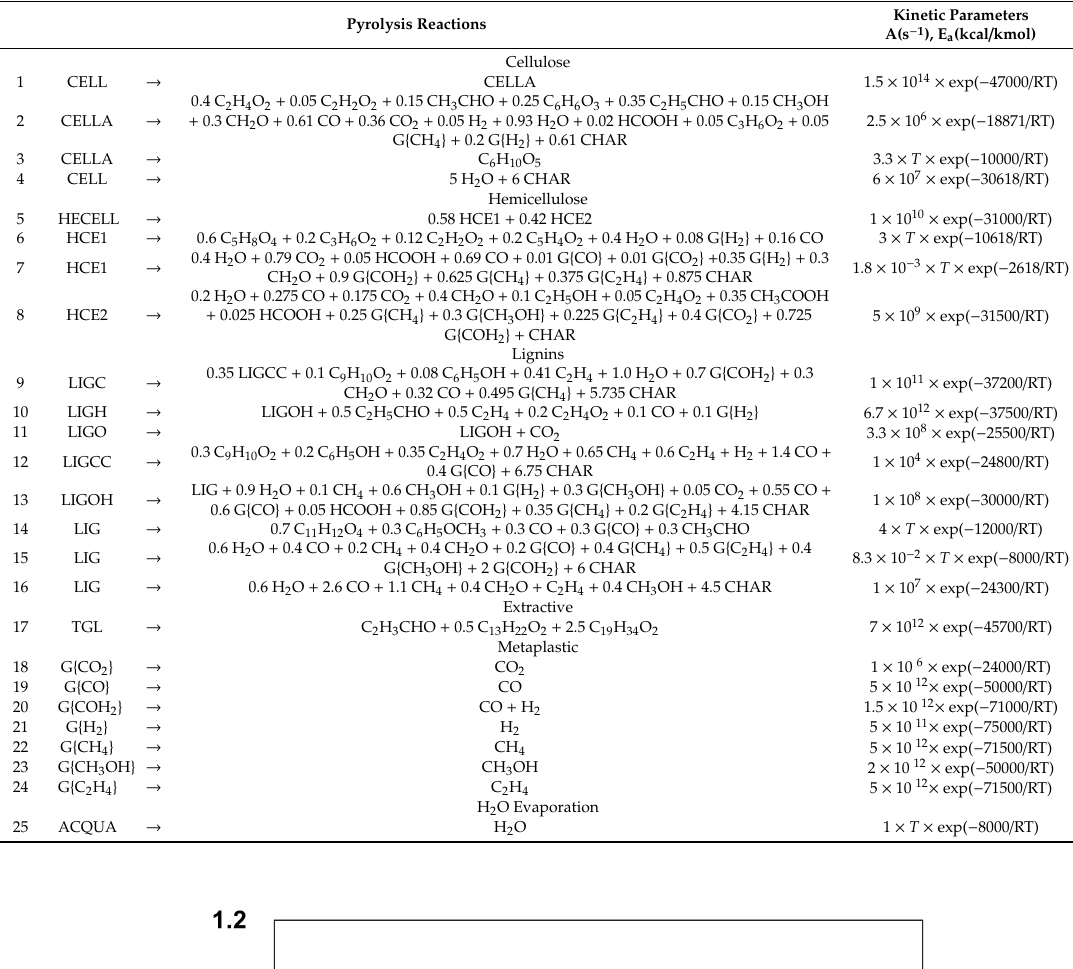
Table 6. Kinetic mechanism of biomass pyrolysis [27].